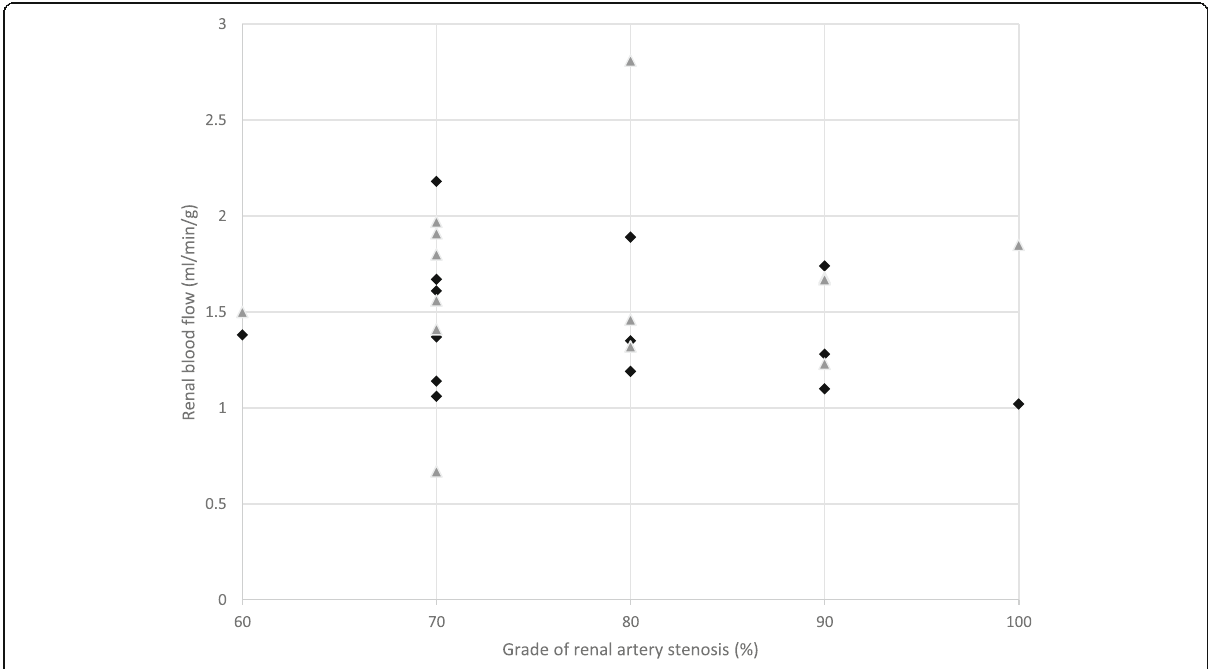
Fig. 2 Grade of renal artery stenosis vs renal blood flow in bilateral RAS. ♦ Grade of renal artery stenosis vs basal flow in bilateral RAS ( r =0.2, p =0.4). Grade of renal artery stenosis vs stress flow in bilateral RAS ( r =0.04, p